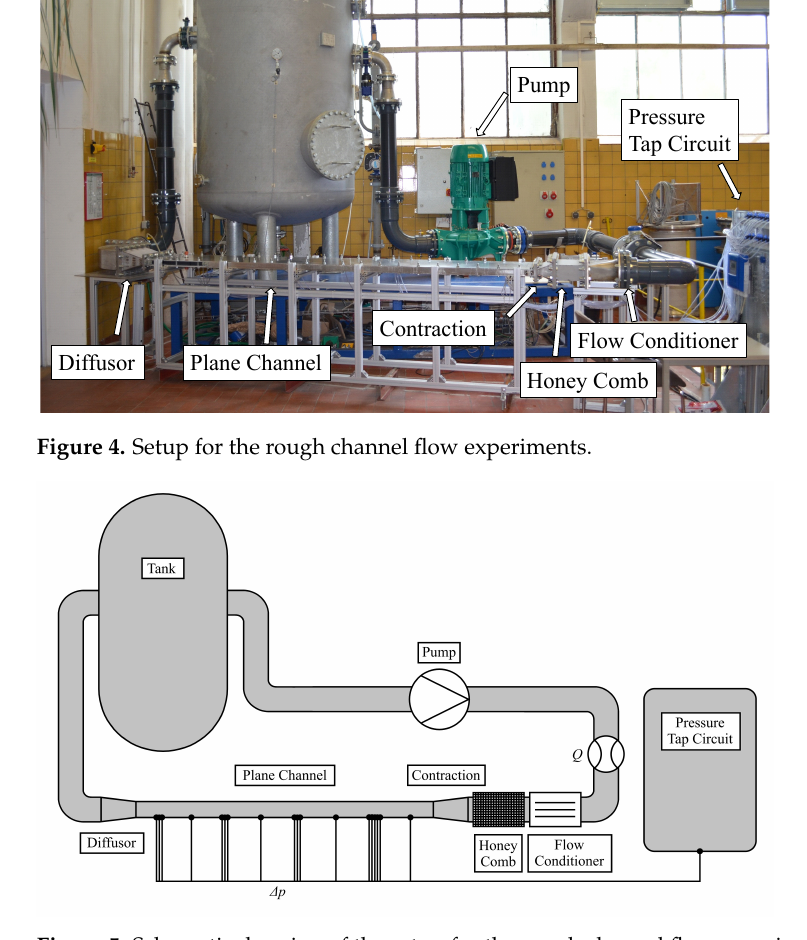
Figure 5. Schematic drawing of the setup for the rough channel flow